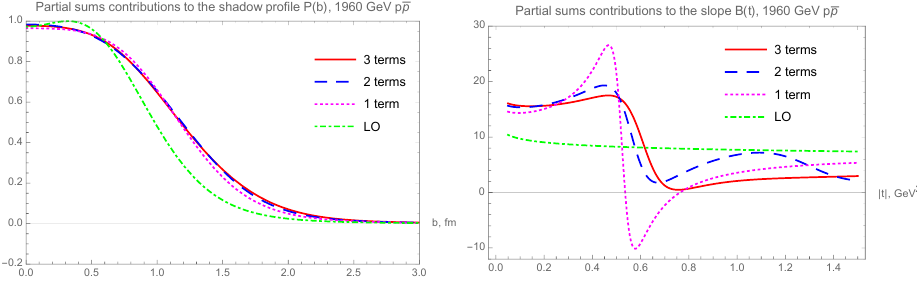
Figure 5. The shadow profile (left) and the elastic slope (right) with partial sums from leading order to third order Levy expansion fitted to the D0 data at √ s = 1 . 96 TeV p ¯ p elastic